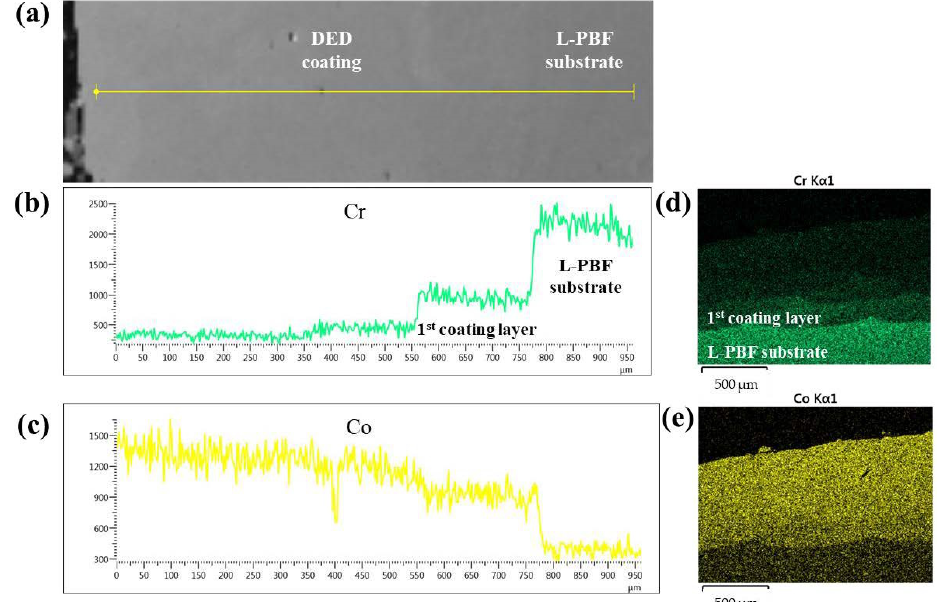
Figure 8. Chemical composition assessed by EDX microanalysis of Cr and Co concentration in 3_T specimen, ( a ) SEM image of coating and substrate zone, ( b ) EDX line scan of Cr distribution, ( c ) EDX line scan of Co distribution, ( d ) EDX scan map of Cr distribution, ( e ) EDX scan map of Co distribution. Optical micrographs of the specimens before the chemical etch disclosed the presence of spherical discontinuities with diameters in the range of 10–30 µ m (Figure 9), which can be considered acceptable in this type of manufacturing process [27].